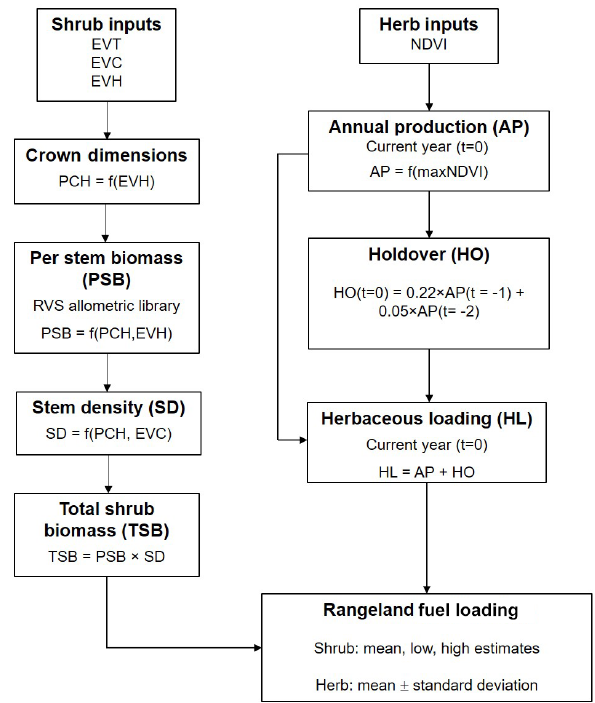
Figure 7. Abbreviated flow of data and actions in RVS to produce rangeland fuel loadings. EVT, EVC, and EVH are existing vegeta- tion type, existing vegetation cover, and existing vegetation height from the LANDFIRE